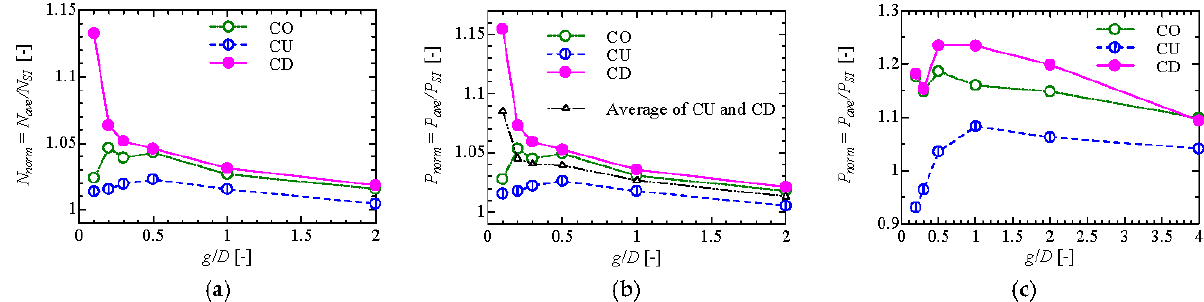
Figure 9. Gap dependence in a pair of VAWT models arranged side-by-side: ( a ) normalized rotational speed by experiment; ( b ) normalized power by experiment; ( c ) normalized power by CFD.